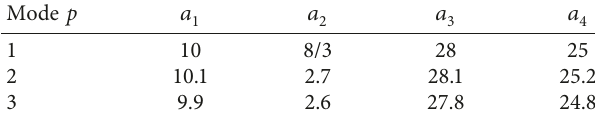
Table 1: Values of a Mode